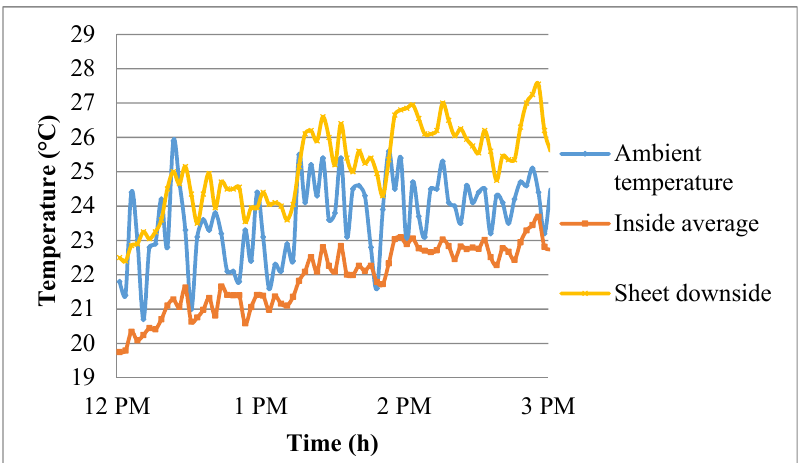
Figure 11. Time dependence of roof sheet temperature and ambient temperature for real cowshed without installation of photovoltaic modules on the roof.